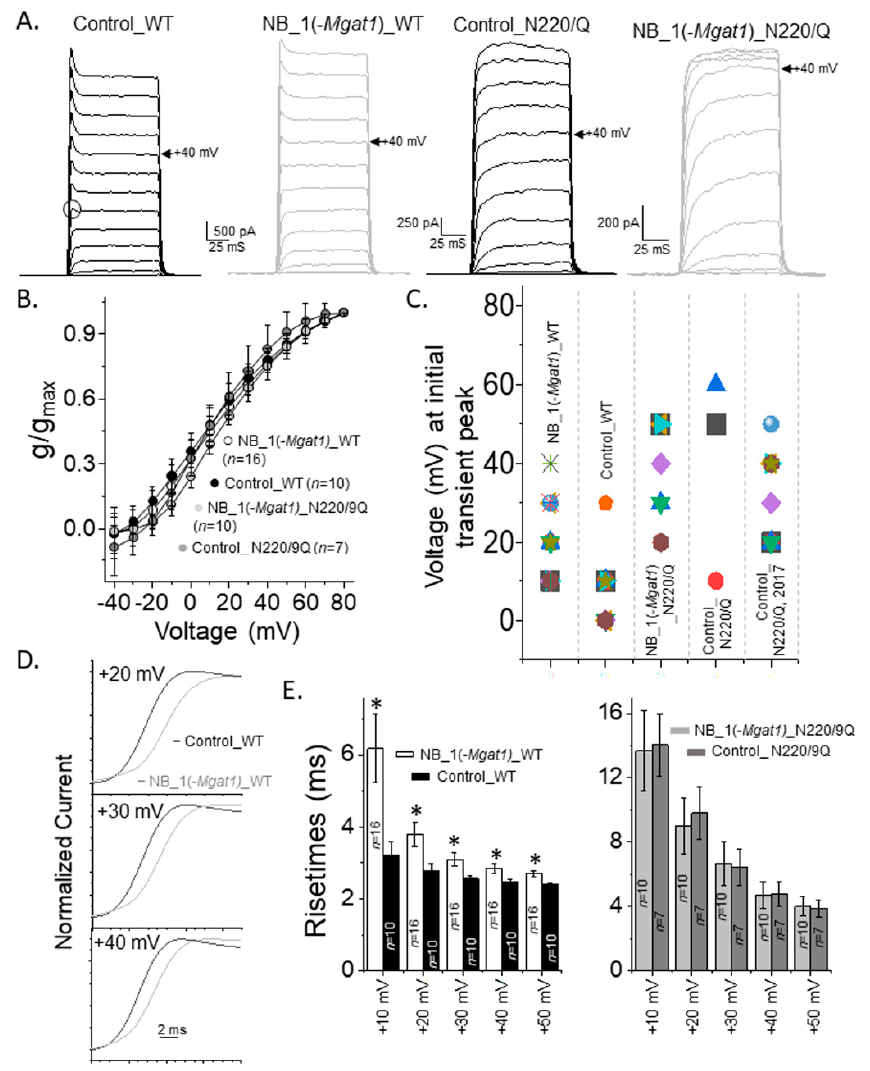
Figure 6. Opening rate of outward ionic current decreased as N-glycan branching is lessened. ( A ) Activation currents were elicited by holding cells at − 50 mV and stepping from − 40 mV to +80 mV in 10 mV increments for 100 ms. Whole cell currents were acquired for glycosylated Kv3.1b expressed in parental (Control_WT) and glycosylated mutant (NB_1( -Mgat1 )_WT) cells and unglycosylated Kv3.1 in the mutant cell line (NB_1( -Mgat1 )_N220/229Q). Open circle denotes transient peak at +10 mV. Control cell line is the parental cell lines, NB_1. Arrow points to current recorded at +40 mV. ( B ) Conductance-voltage (g/gmax) curves obtained from non-inactivating currents with and without transient peaks expressed by glycosylated (WT) and unglycosylated (N220/229Q) Kv3.1b in NB_1 and NB_1(- Mgat1 ). ( C ) Scatter plot illustrating voltage at which the initial transient peak was observed from non-inactivating current with transient peaks of the various cell lines and those from our past reports [16]. ( D ) Whole cell currents from activation voltage protocols in ( A ) were expanded for Control_WT and NB_1 (-Mgat1 )_WT cells lines. ( E ) Rise times of activation currents of the WT Kv3.1 (left panel) and N220/229Q (right panel) expressing cell lines. Data are presented as the mean ± SEM and were compared by Student’s t-test (* p < 0.05).